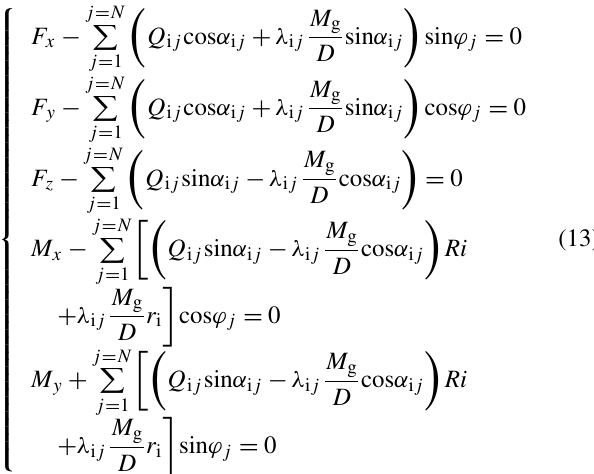
Where ω is the angular velocity of inner